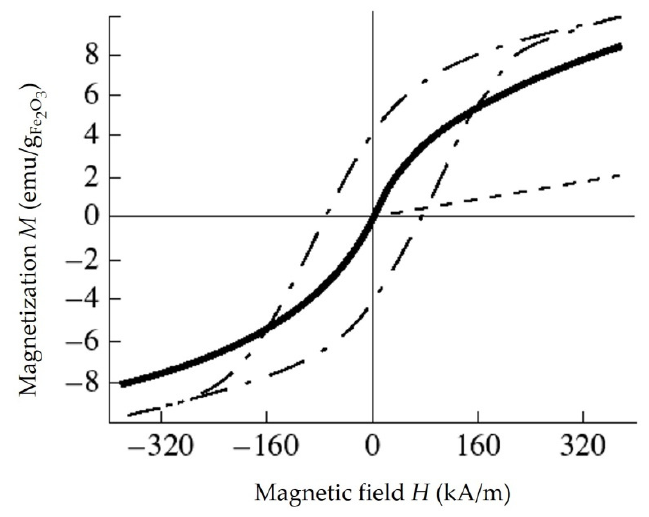
Figure 21. Experimental dependencies of magnetization M on magnetic field H for a sample containing 5 mass. % γ -Fe 2 O 3 in a polyethylene matrix at a temperature of 293 K. The dotted line and dotted line with dots correspond to paramagnetism and ferromagnetism, respectively. Adapted from [181] with permission.